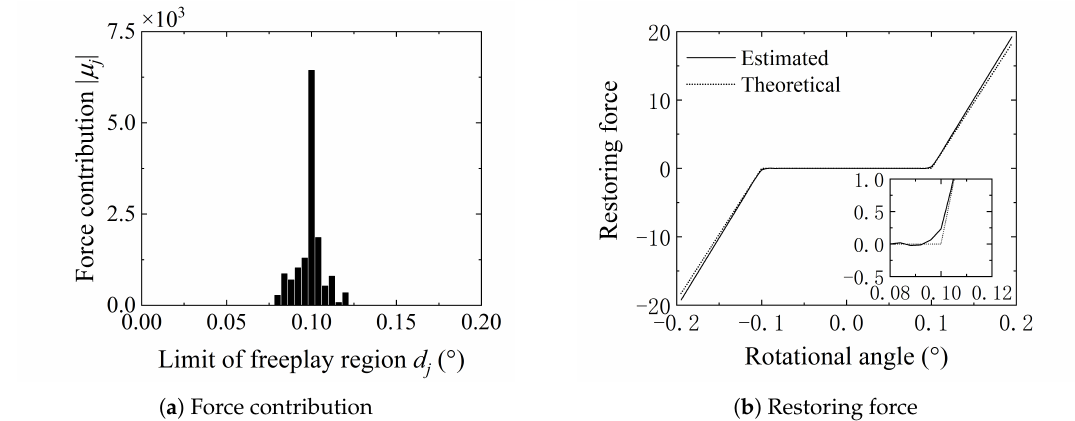
Figure 9. The identification of central freeplay using the 2nd displacement range [ 0.08 ◦ ,0.12 ◦ ]